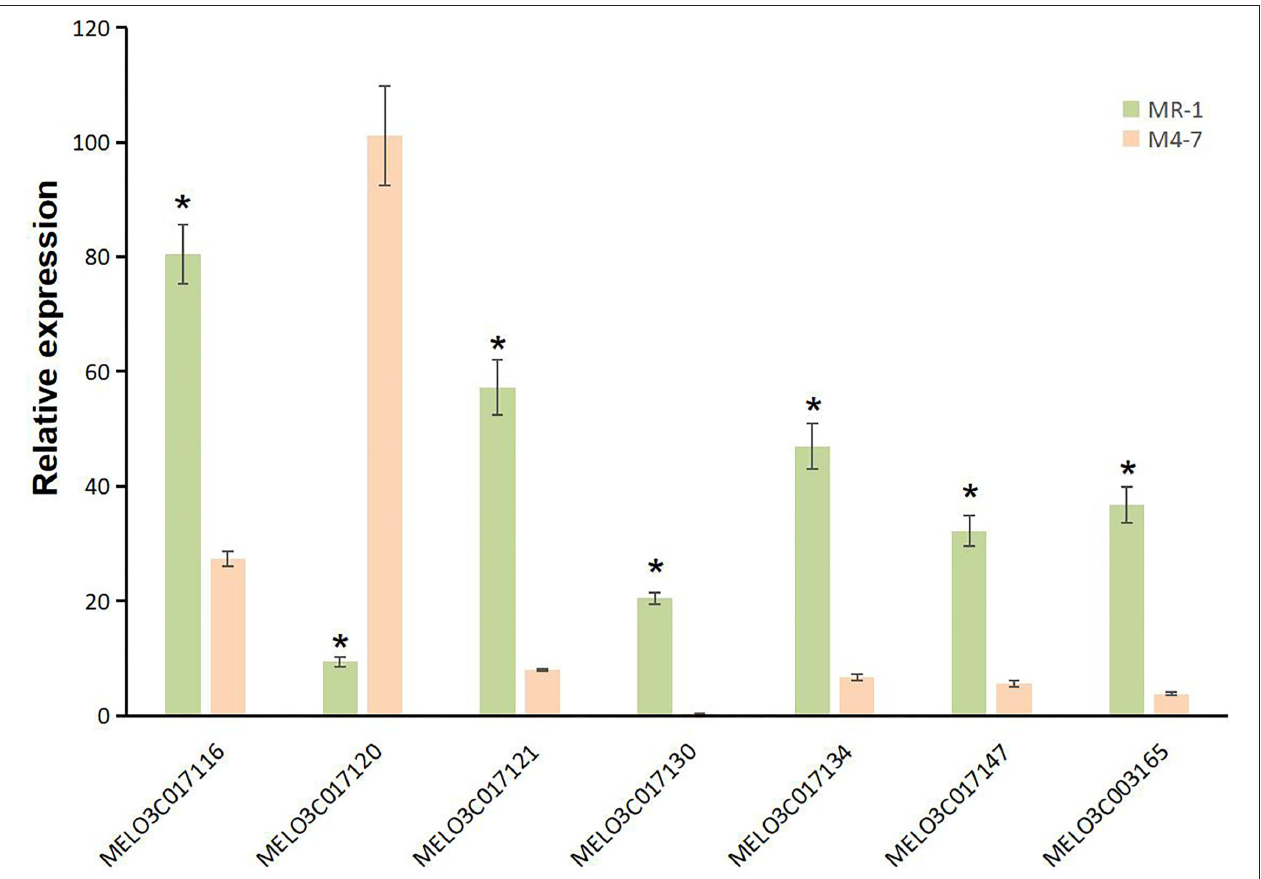
FIGURE 7 | Expression analysis for candidate genes with non-synonymous single-nucleotide polymorphisms (SNPs) on chromosome 2 ( MELO03C017116 , MELO03C017120 , MELO03C017121, MELO03C017130 , MELO03C017134 , and MELO03C017147 ) and chromosome 8 ( MELO03C017165 ). * represents the presence of significant